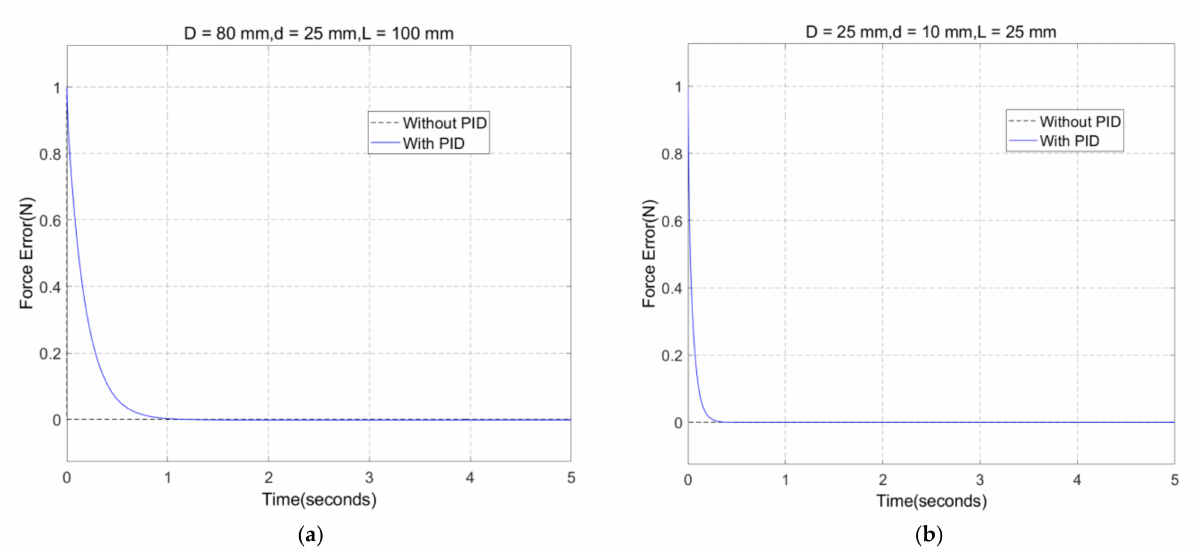
Figure 18. Force error curves before and after PID correction. ( a ) D = 80 mm, d = 25 mm, L = 100 mm; ( b ) D = 25 mm, d = 10 mm, L = 25 mm.